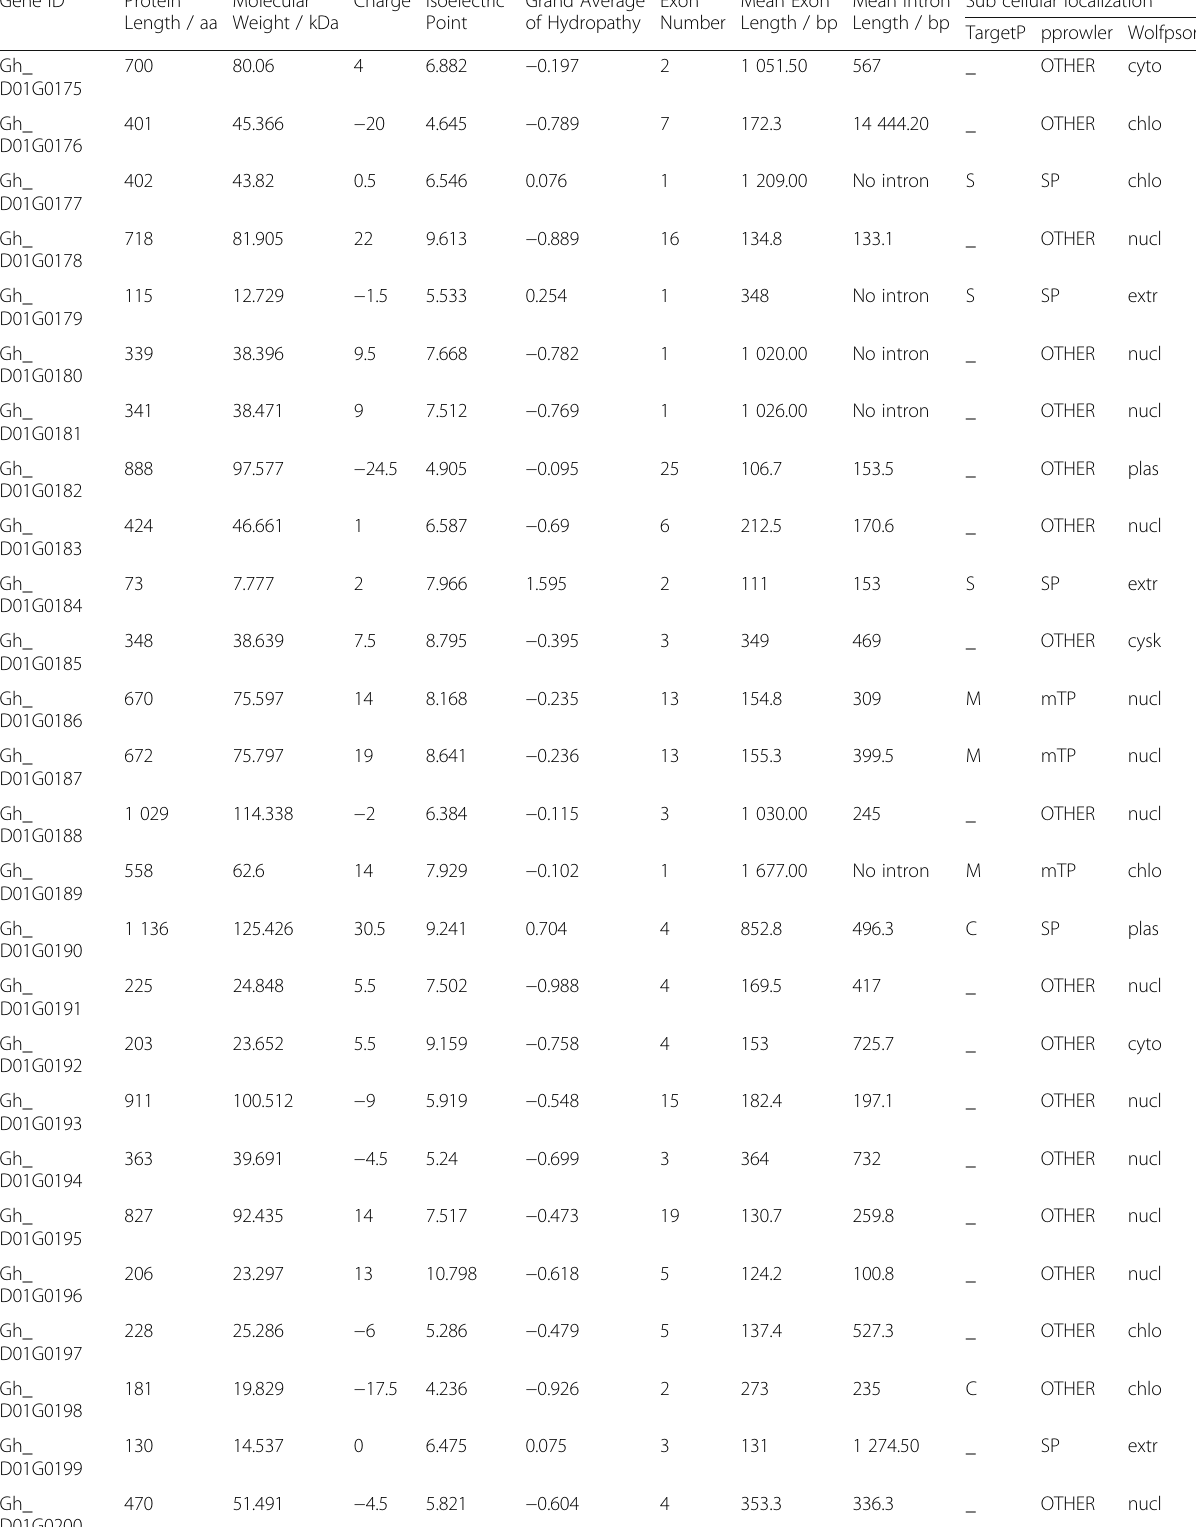
Table 3 Physiochemical properties and sub cellular localization prediction of the mined genes within the major clusters of the consistent QTLs (Continued) Gene